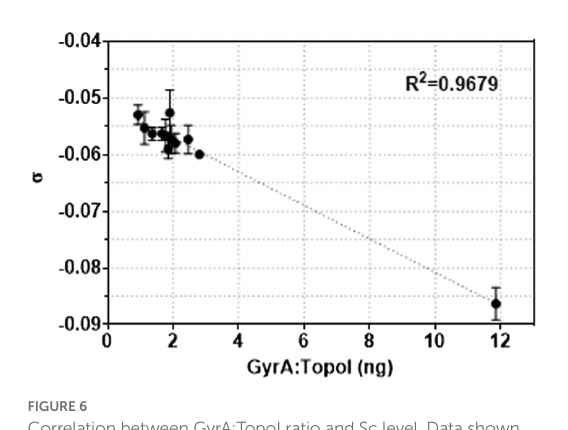
FIGURE 6 Correlation between GyrA:TopoI ratio and Sc level. Data shown are σ values (mean ± SD of three independent replicates) estimated in 2D-agarose gels and GyrA:TopoI ratio (in ng). Data correspond to samples of strains R6, P Zn topA and ∆ topA P Zn topA grown in different ZnSO 4